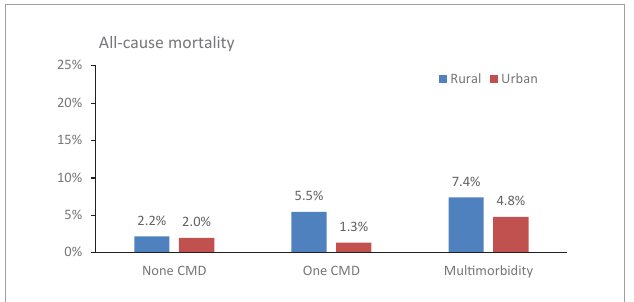
FIGURE1 The all-cause mortality from 2011 to 2018 by the number of disease and residence place. CMD, cardiometabolic disease.